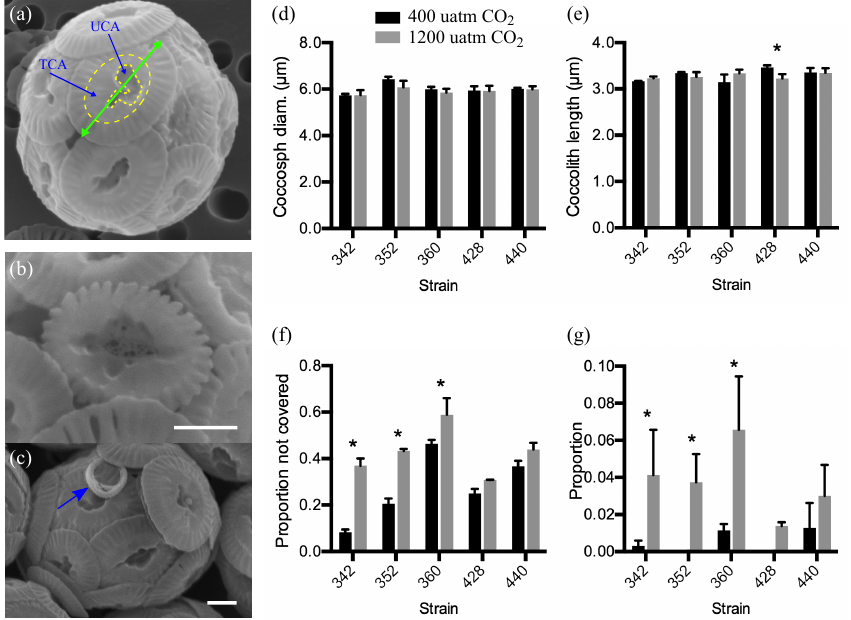
Figure 6. Effects of high-CO 2 –low-pH conditions on coccolithophore morphology. (a) Example illustrating coccolith measurements taken including coccolith length (solid line with two arrow heads), total central area including the inner tube (TCA) (defined by inner terminal of radial elements), and the part of the central area that is uncovered by tube elements (UCA). (b) Example of a coccolith classified as incomplete or malformed. (c) Example of a very incomplete coccolith (arrow). (d) Coccosphere diameters. (e) Coccolith length. (f) Proportion of central area not covered. (g) Proportion of coccoliths that were malformed or incomplete. See Table 4 for global two-way ANOVA results. The ∗ indicates significant difference ( p < 0 . 05) in pairwise comparison between the two CO 2 treatments for a given strain, as judged by Sidak post hoc testing with correction for multiple